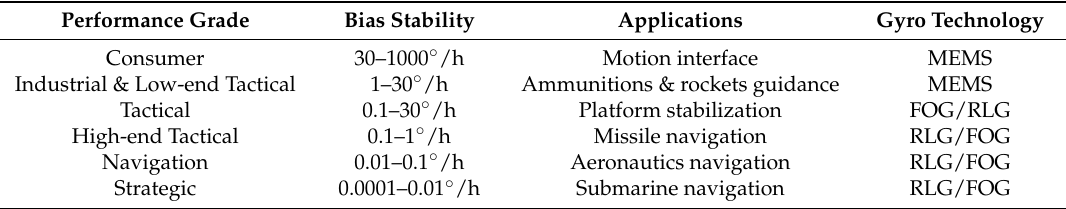
Table 1. Gyro technology comparison in terms of Bias Stability.